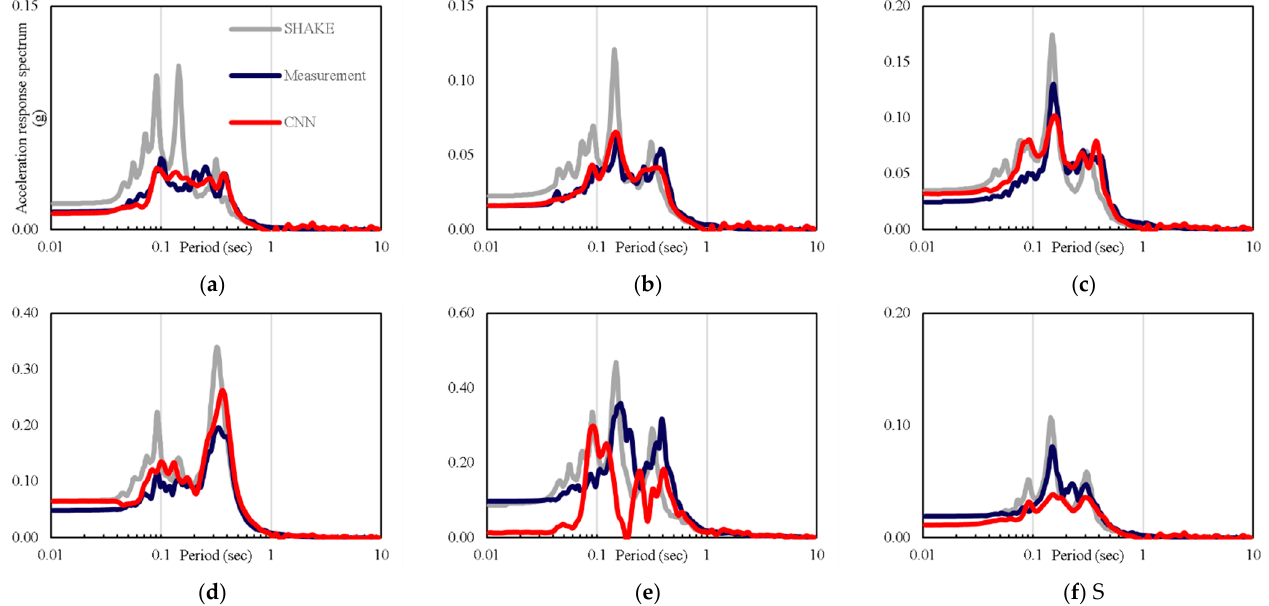
Figure 13. The six samples of acceleration response spectra measurements and predictions at site IBRH13. ( a ) IBRH131412201830.EW. ( b ) IBRH131412201830.NS. ( c ) IBRH131611240623.NS. ( d ) IBRH131908041923.EW. ( e ) IBRH131611220559.NS. ( f ) IBRH132006250447.NS.